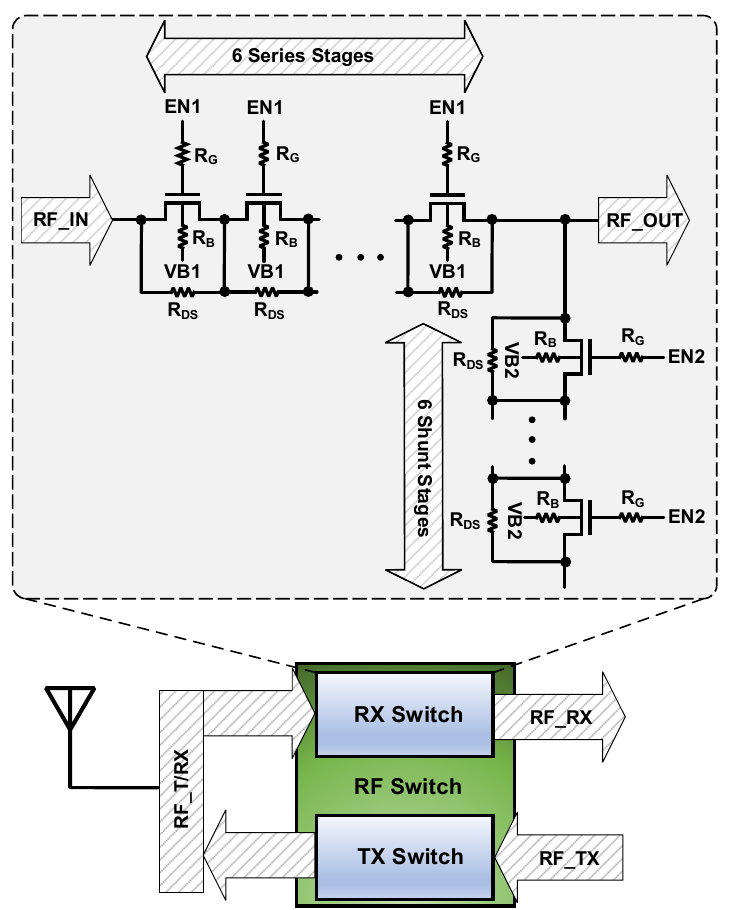
Figure 2. Schematic of the designed SPDT T/R RF